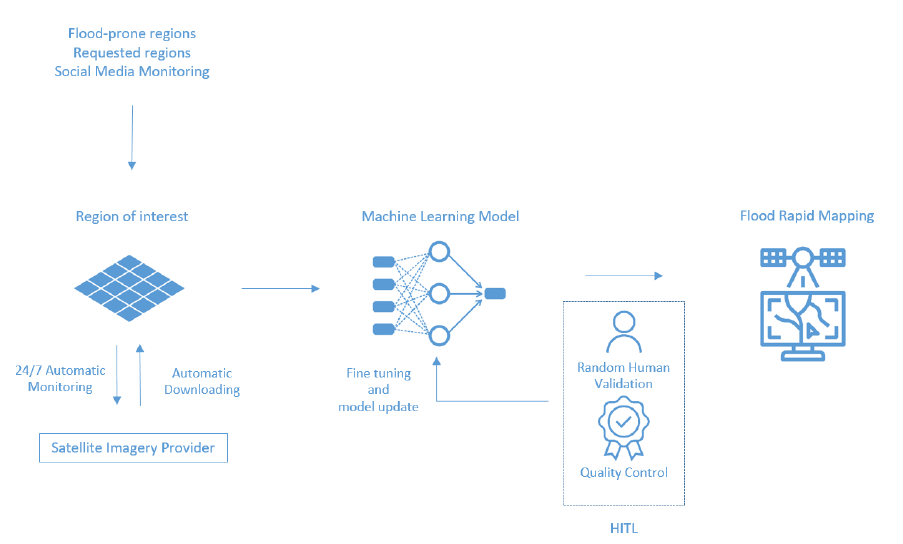
Figure 12. A possible configuration for a fully automated pipeline for AI-based Rapid Mapping. The image related to the region of interest would be automatically downloaded and ingested into the machine learning model which outputs flood polygons. The region of interest could be defined by flood-prone regions, regions requested by the user, or automatically triggered by additional data input such as social media monitoring. In addition, a random human validation could be integrated to test and fine-tune the